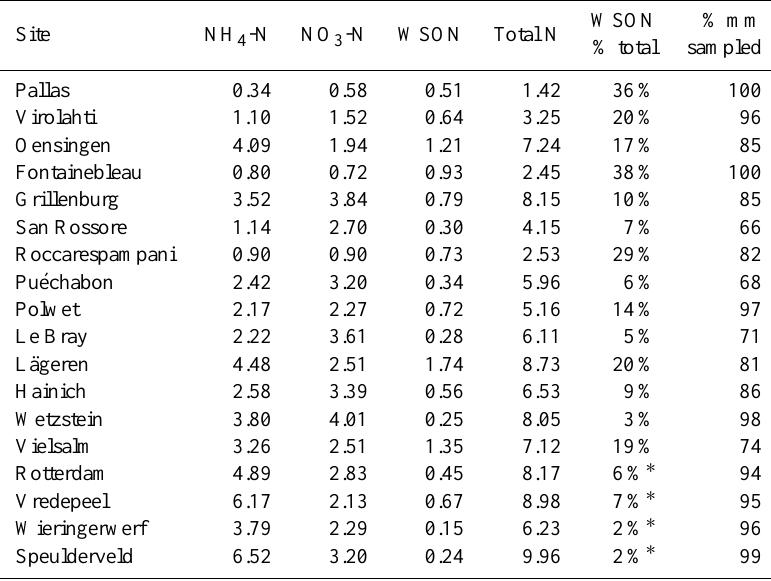
Table 2b. Average wet deposition of N (kgNha − 1 yr − 1 ) at all sites, from data in Table 2a.